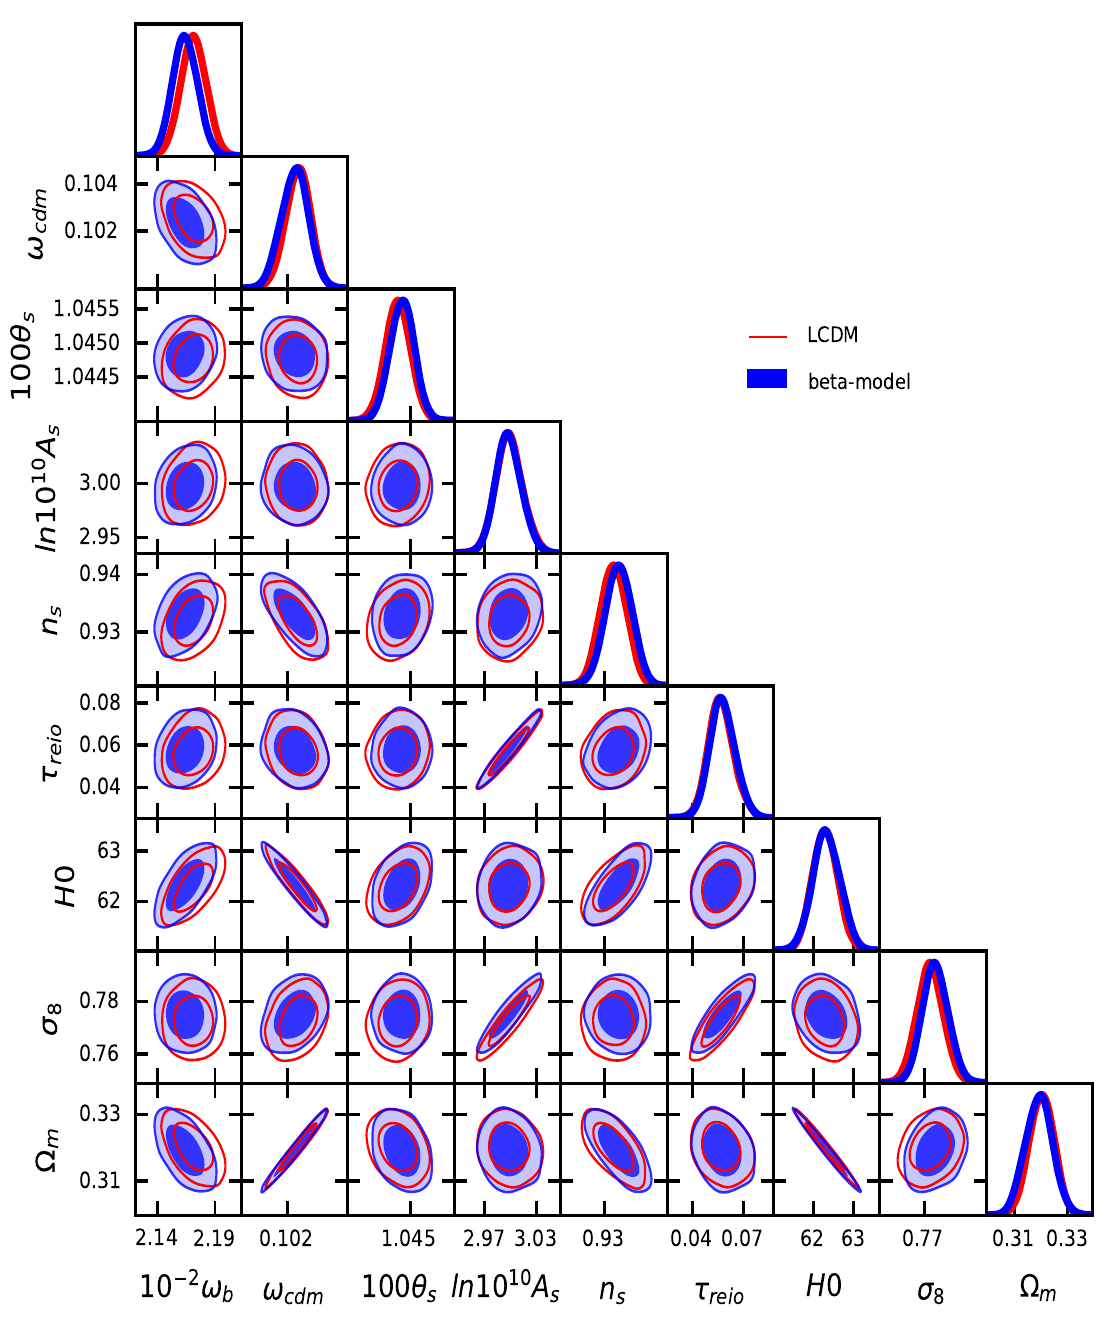
Figure 1. The one-dimensional marginalized posterior distributions and two-dimensional contour plots with 68.4% and 95.7% C.L. Blue and red colors indicate the β -model and Λ CDM, respectively. (For interpretation of the references to color in this figure legend, the reader is referred to the web version of this